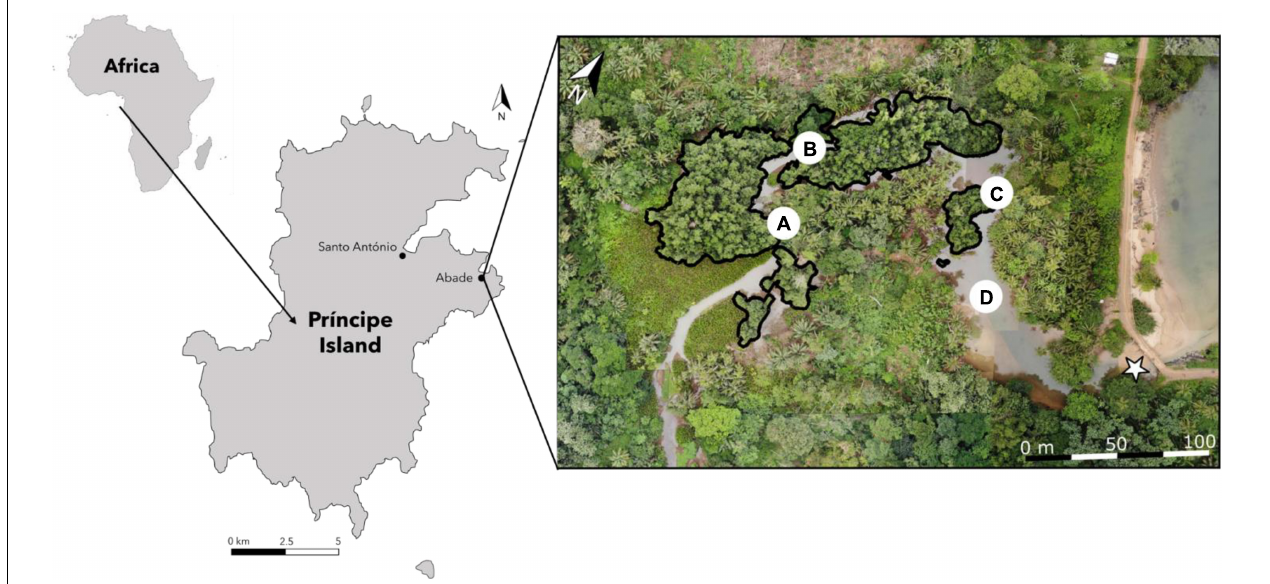
FIGURE 1 | Map of the Praia Salgada mangrove stand (on the right ) and respective location in Príncipe Island and African continent (on the left ). Black perimeter in the mangrove indicates the distribution of the mangrove tree Rhizophora harrisonii . Sampling sites: A – upper; B – middle; C – lower; and D – outer. Points A–D represent the sampling points for the water column characterization, and points A and C correspond to the fishing points. (cid:73) – location where the sandbank was formed. The map of Praia Salgada mangrove stand (on the right ) was constructed with aerial photography obtained with a